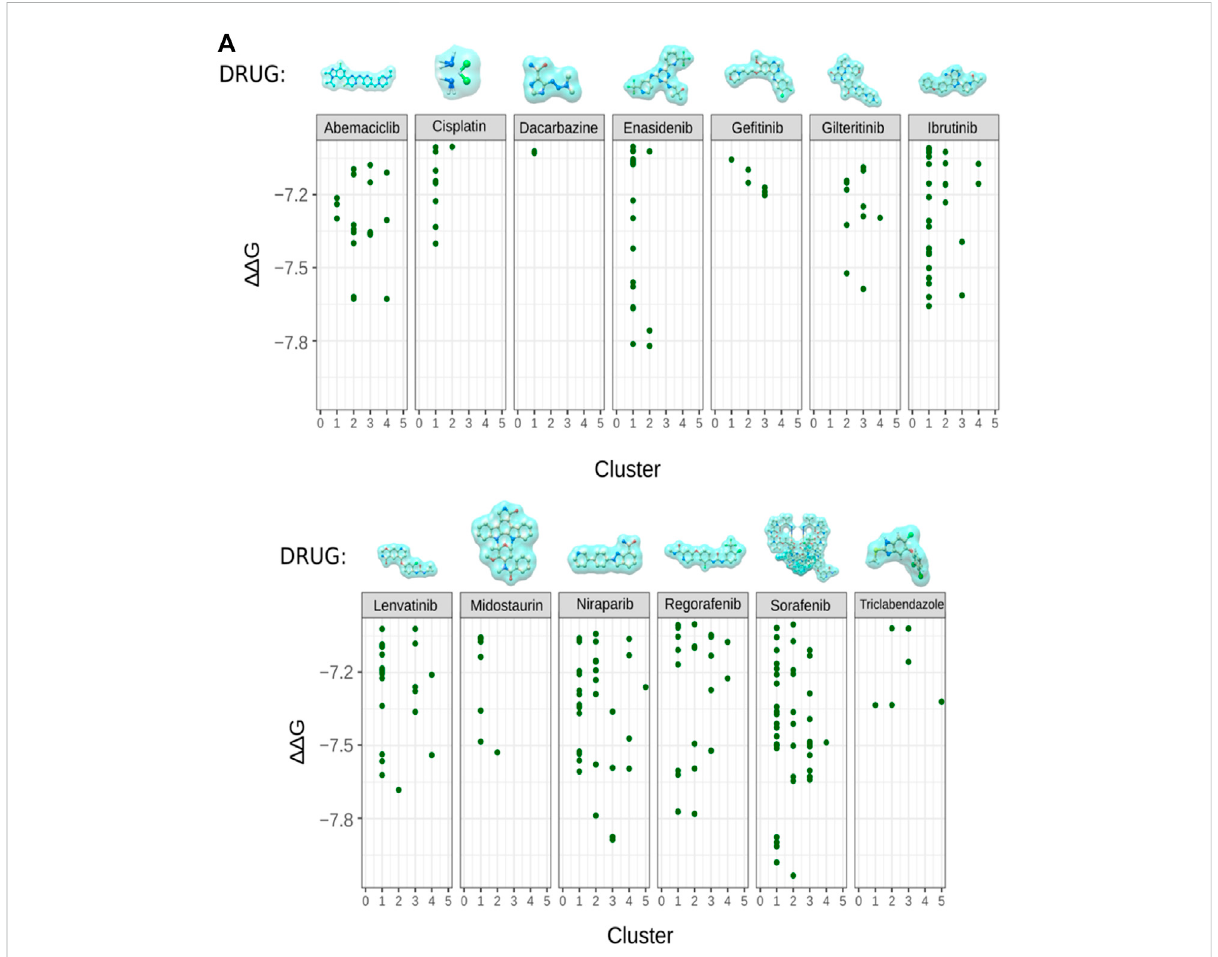
FIGURE 3 Cancer related drug molecule and their docking with RUNX1. (A) Docking of enasidenib (AML), sorafenib (AML), and niraparib (ovarian cancer) with RUNX1-ETS DNA complex displaying the binding position of drug molecules with their ΔΔ G values. Showing comparison of docking scores for all 13 drug molecules with RUNX1, we took AML associated drug molecules as positive controls for docking with RUNX1. Sorafenib, regorafenib, niraparib, and enasidenib were indicated by the modeling to have low ΔΔ G values suggestive of their drug